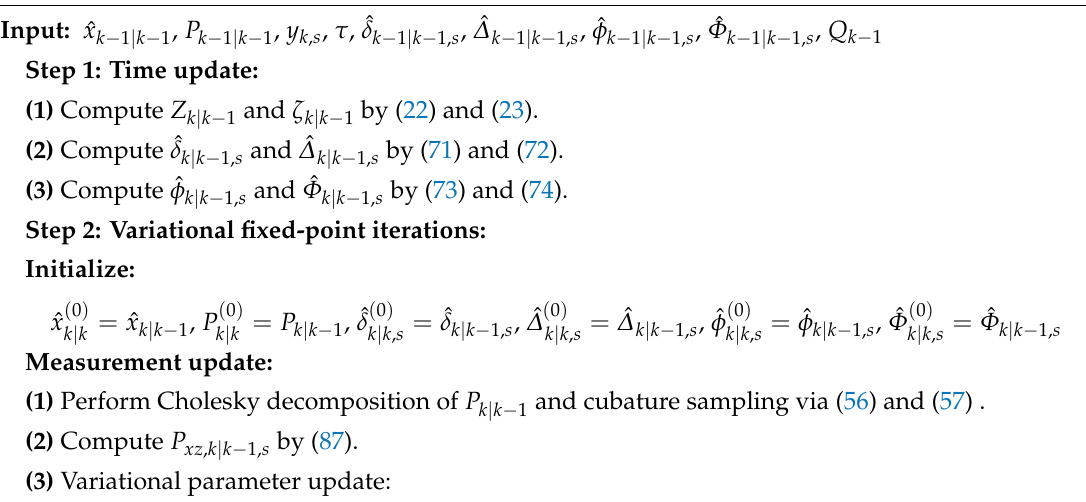
Algorithm 2 Time-recursion of